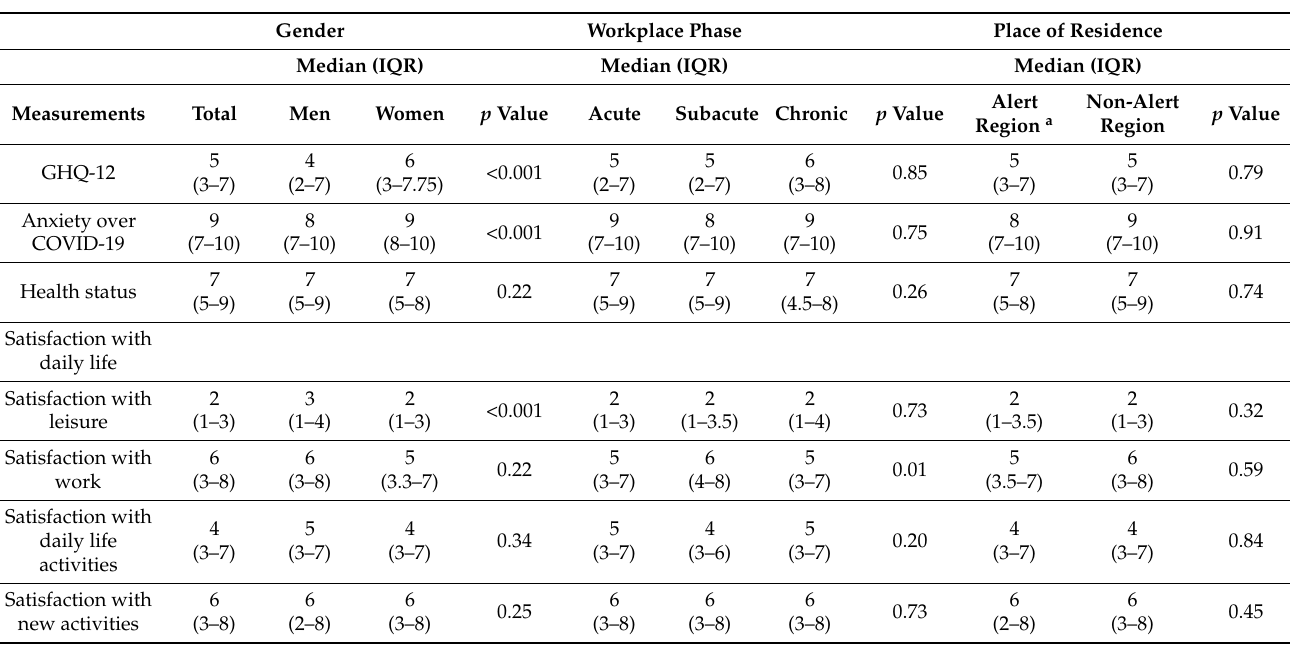
Table 2. Mental health measurements according to gender, clinical workplace phase, and place of residence ( N =